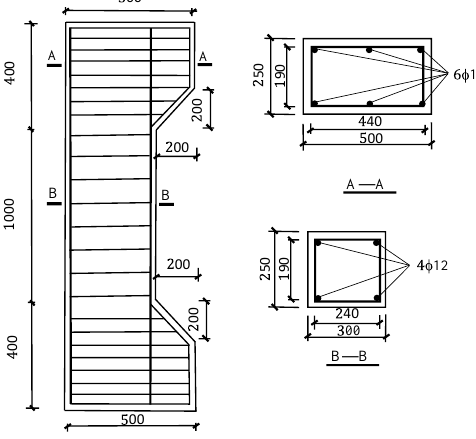
Figure 1. Geometry of column specimen (considering SSRC1 as an example; units: mm). Table 2. Specimen specifications.